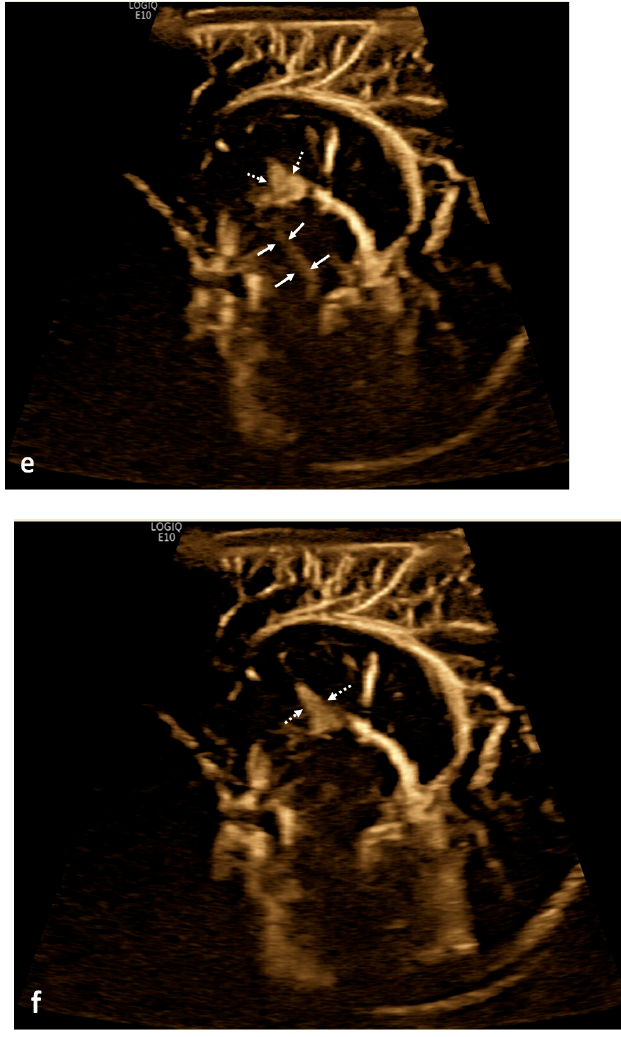
Figure 2. Cerebrospinal fluid (CSF) flow visualized in a patient with post-hemorrhagic hydrocephalus. A 7-day-old boy with a history of severe intraventricular hemorrhage and ventriculomegaly. Coronal and sagittal grayscale ultrasound shows enlargement in the lateral and third ventricles, as well as evolving choroid plexus hemorrhage and fine granular mobile debris in the ventricles ( a – c ). The parenchymal evaluation shows grade IV left parieto-occipital periventricular hemorrhage ( c ). Sagittal B-Flow ( d – f ) demonstrates turbulent caudocranial CSF flow from the cerebral aqueduct (arrows) into the third ventricle (dotted arrows). The entire clip is provided as Supplemental Material